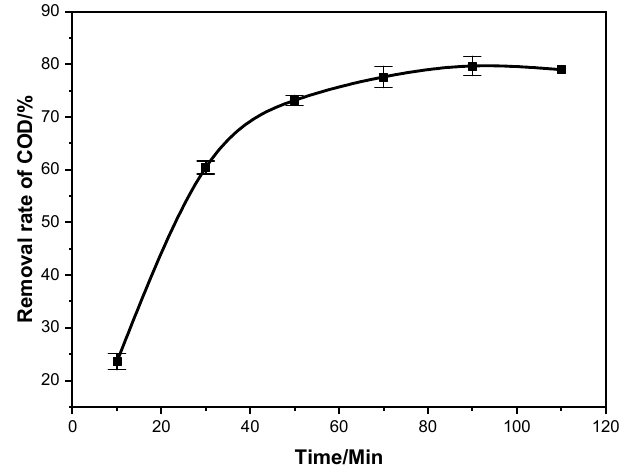
Figure 6. Effect of electrolysis time on mixed wastewater COD removal rate (anode material: Fe, cathode material: Stainless steel, current density: 19.23 mA/cm 2 , pH: 7.1).